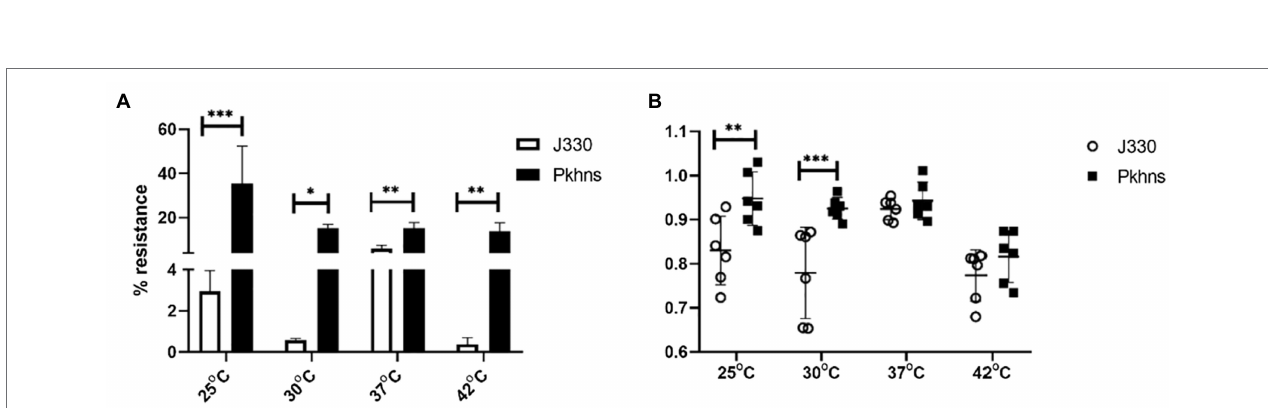
FIGURE 6 | The impact of temperatures on IncX3 plasmid stability (A) and fitness cost (B) in Escherichia coli . (A) Plasmid stability is estimated by the percent of plasmid-containing E. coli at 24 h as determined by resistance to meropenem. (B) Fitness index is calculated by formula described in Section “Materials and Methods.” The higher fitness index represents better fitness of plasmid-containing strains. Significant differences between temperatures are indicated with asterisks: * p < 0.05, ** p < 0.01, and *** p < 0.001.